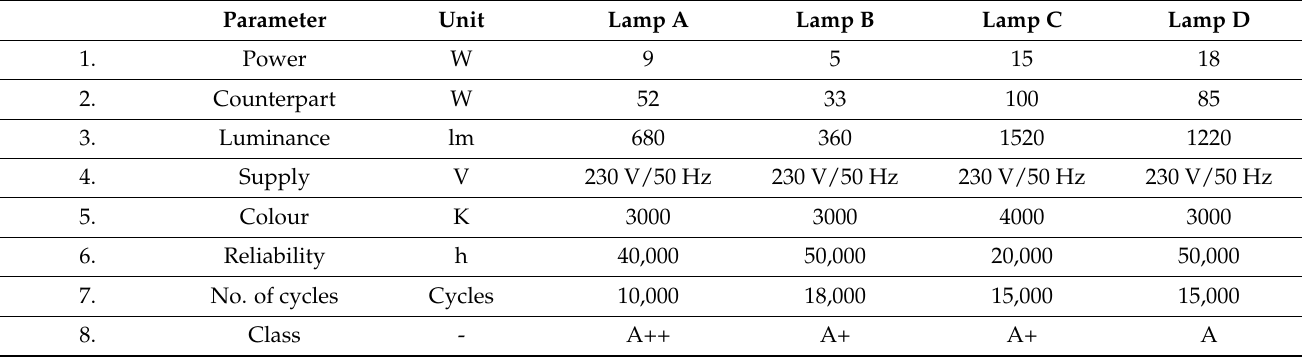
Table 4. Basic parameters of the tested